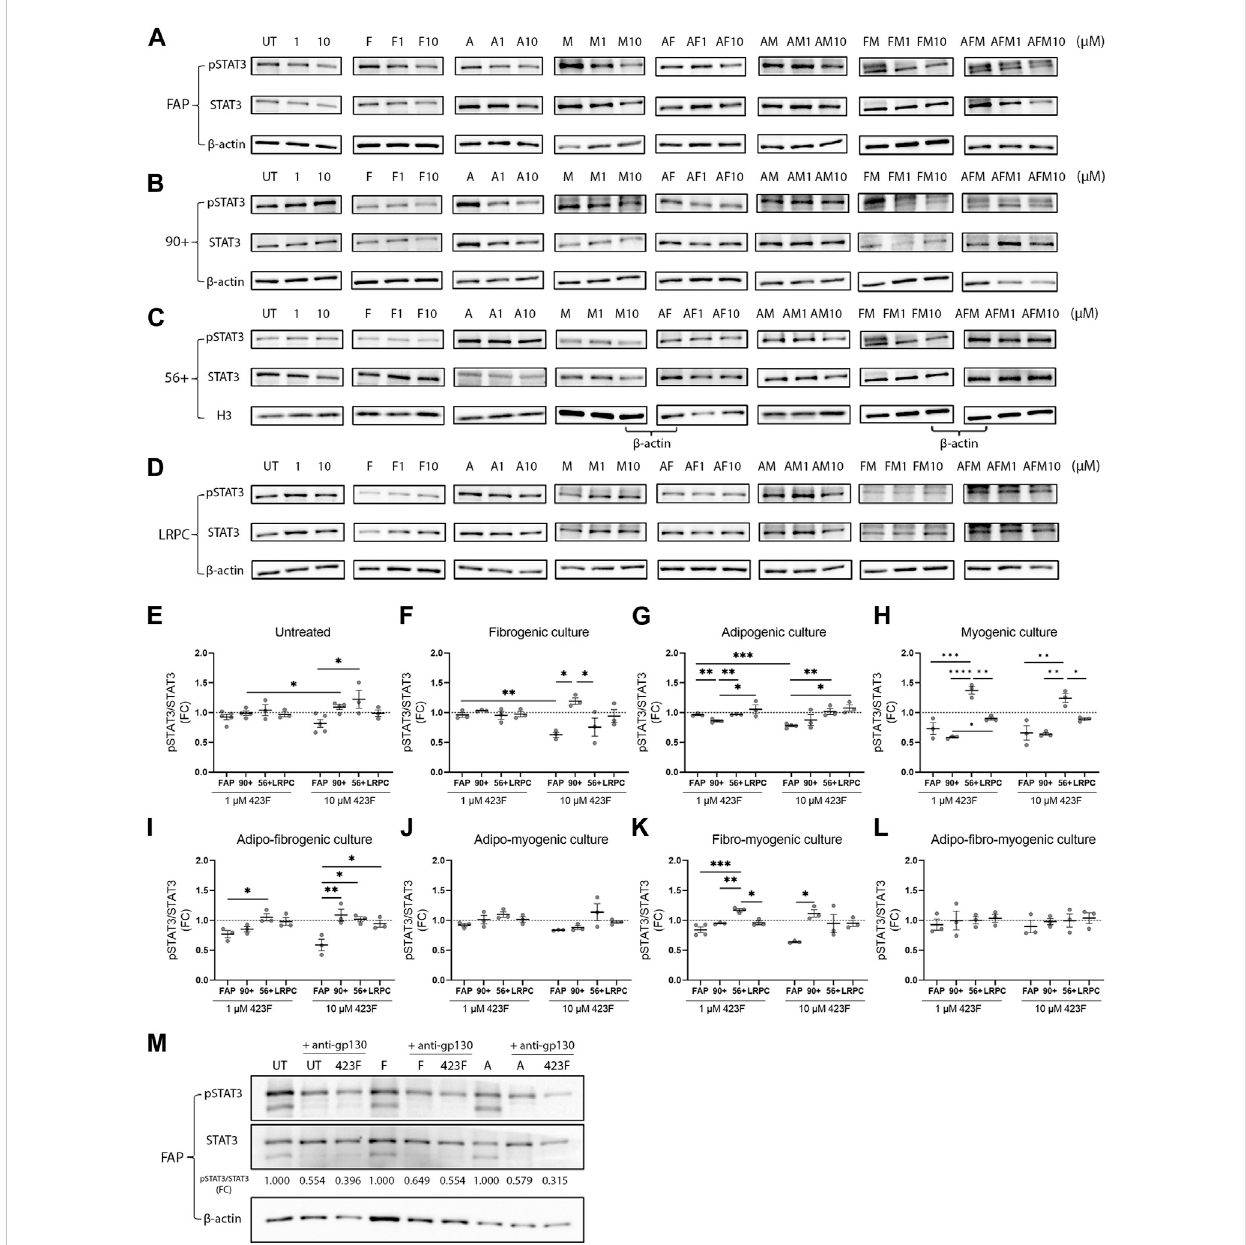
FIGURE 7 423F-mediated modulationofSTAT3expressionandactivityinculturesofhumanmusclecellsubsets. (A – D) Representativeimagesofwesternblot analysesofpSTAT3andSTAT3fromFAP (A) ,CD90 (B) ,CD56 (C) ,andLRPC (D) whole-celllysatesharvestedafter24-hintheindicatedcultureconditions. (E – L) Levels of pSTAT3 were related to total-STAT3 levels for each cell subset at the indicated conditions. Data (mean ± SEM) was pooled from